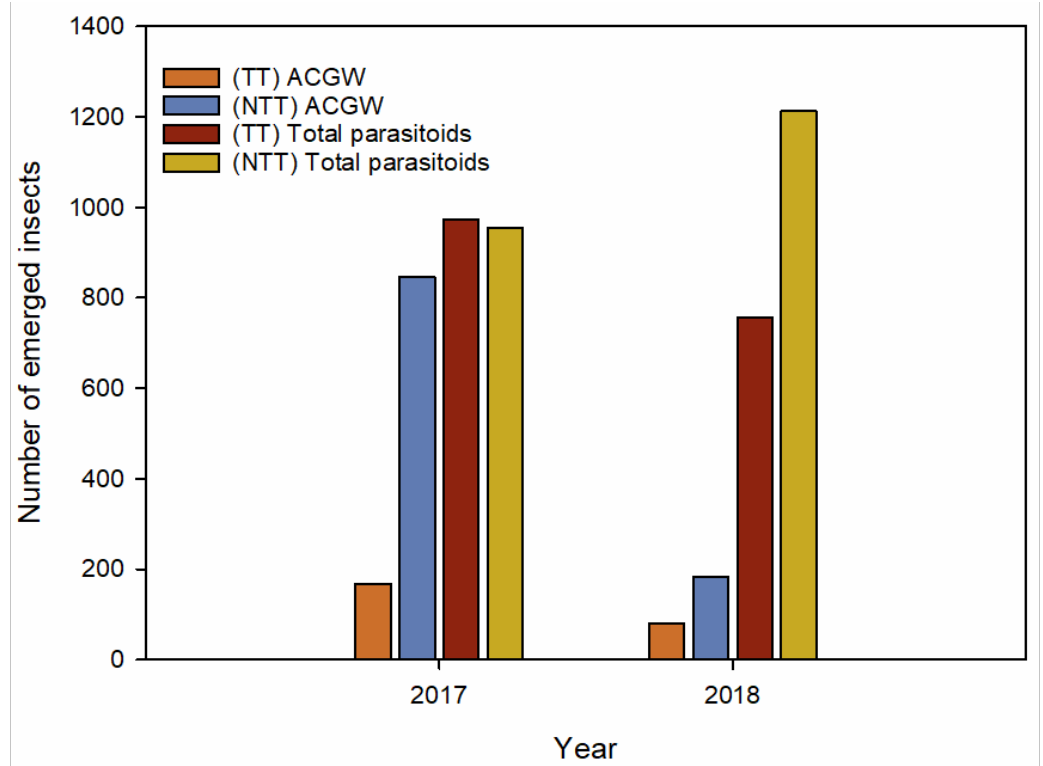
Figure 2. Bar charts depicting the number of Asian cynipid gall wasps (ACGWs) and parasitoids in cold-stressed (TT) galls and non-cold-stressed (NTT) galls collected in different years from different fields. For experimental details, see the text. Data from the three examined chestnut fields were